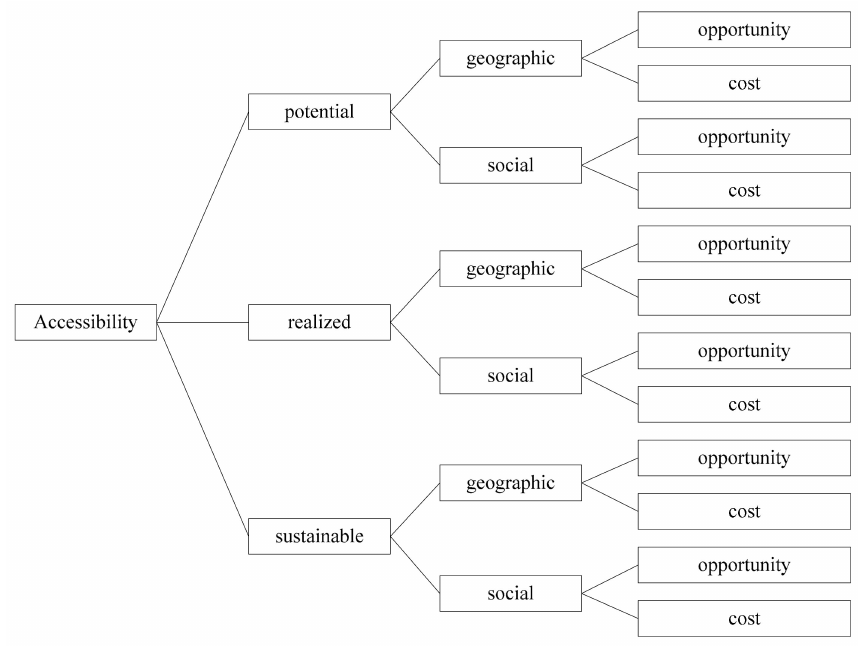
Figure 1. The analysis dimensions of the accessibility of healthcare services for the